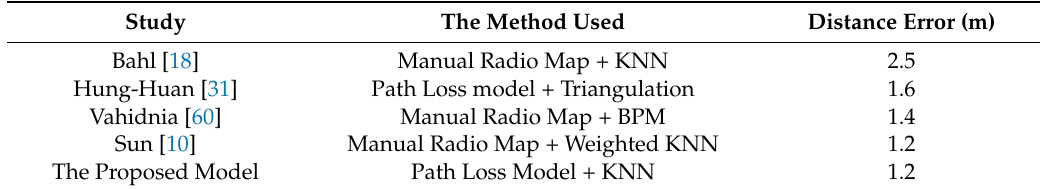
Table 2. Related work floor positioning techniques and distance